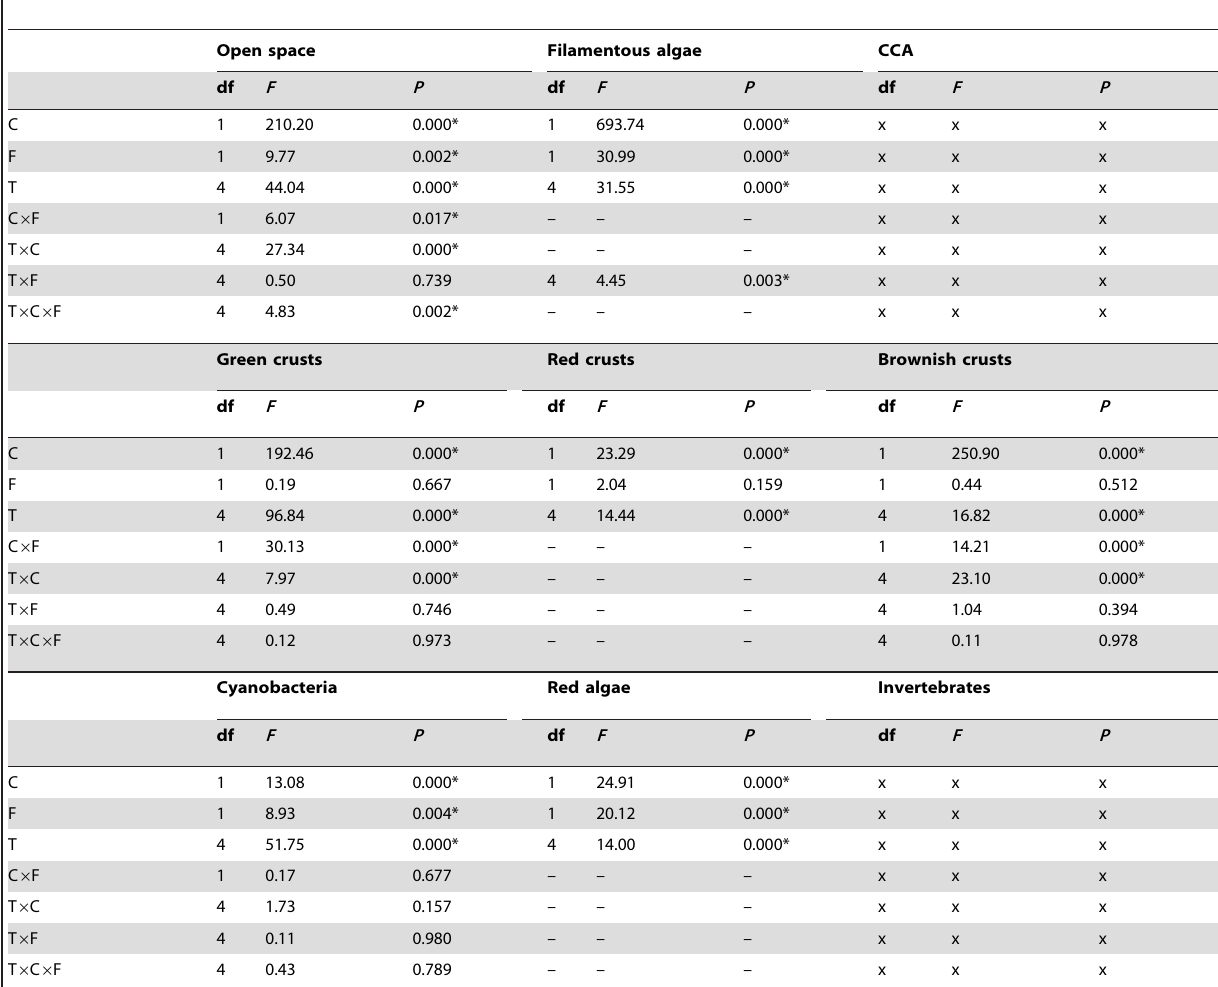
Table 3. Results of 3-factorial generalized linear model (GLM; binomial distribution and logit function) of functional algal groups of light-exposed